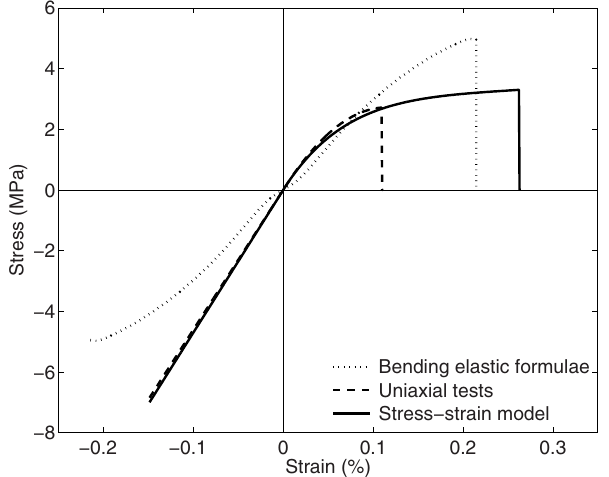
Figure 6. Measured and identi(cid:12)ed stress-strain curves for aluminium titanate